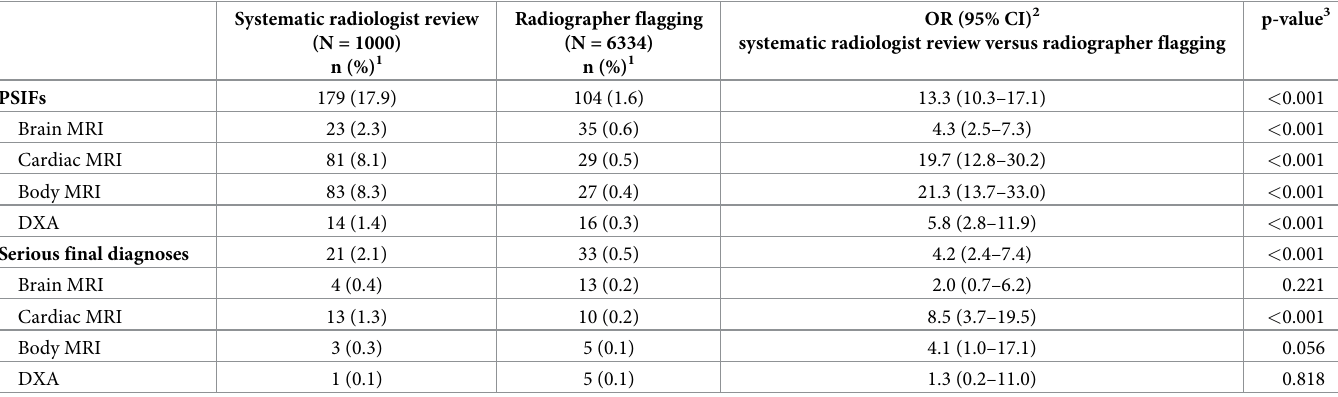
Table 2. Odds ratios for potentially serious incidental findings (PSIFs) and serious final diagnoses comparing two